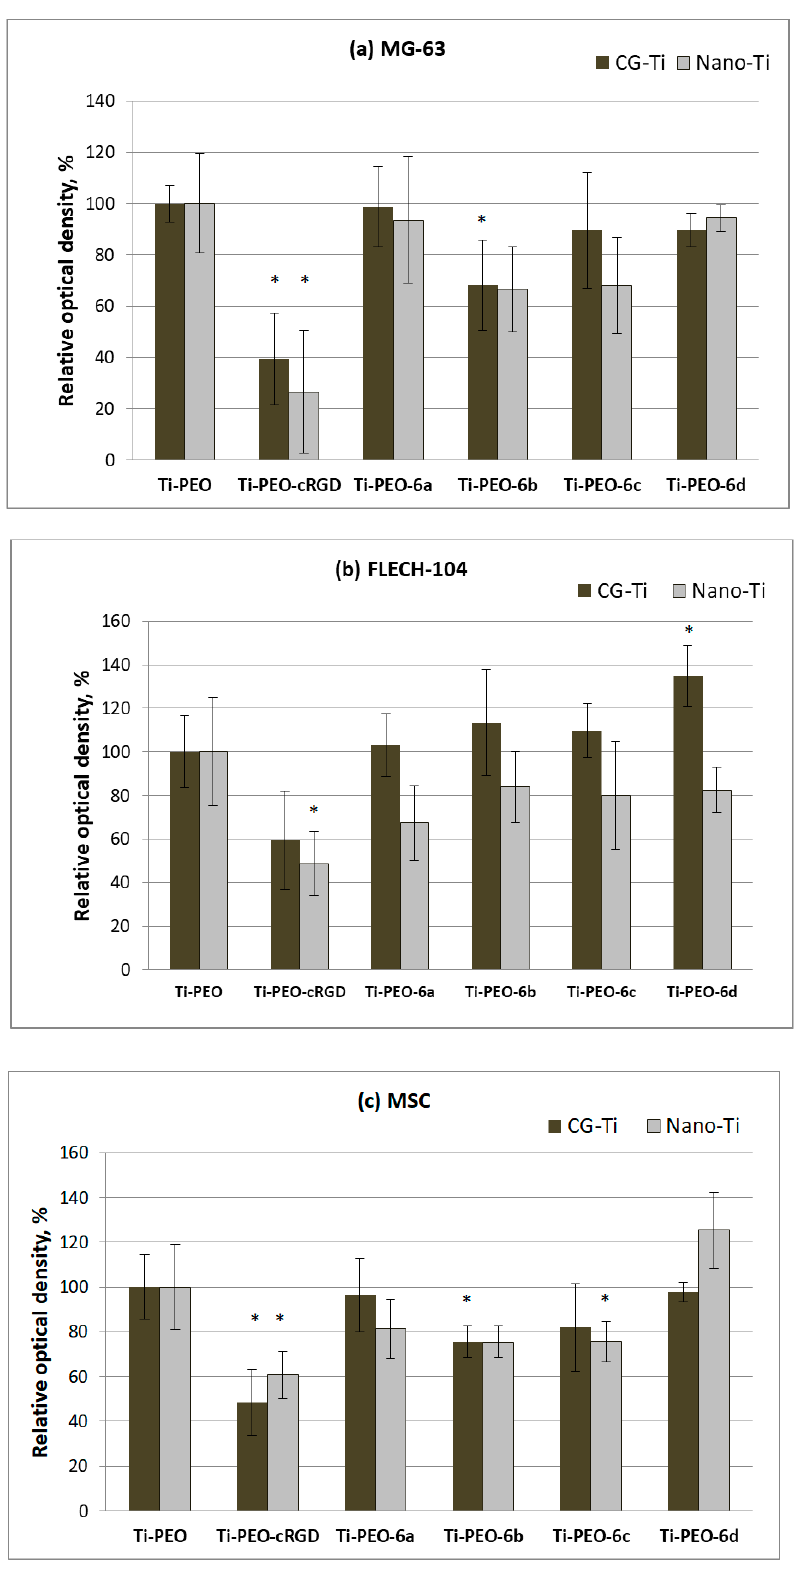
Figure 5. EZ4U in vitro assay of the growth of MG-63 osteoblasts ( a ), FLECH-104 fibroblasts ( b ), and adipose-derived MSCs ( c ) cultivated within 7 days on Ti-PEO samples coated with compounds c(RGDfC), 6a – d . Significant differences with the control ( p < 0.05) are shown with asterisks.